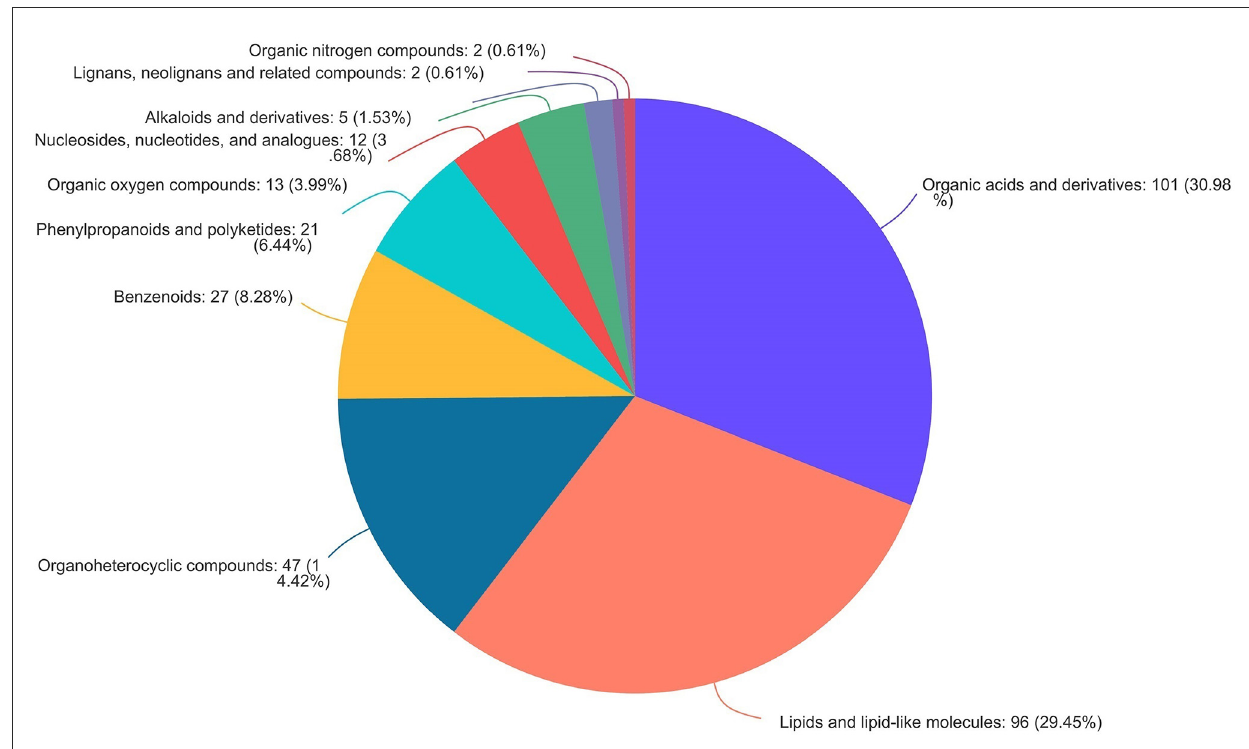
FIGURE10 Pie chart of HMDB chemical taxonomy (super class) analysis of the caecal metabolites ( n = 6).